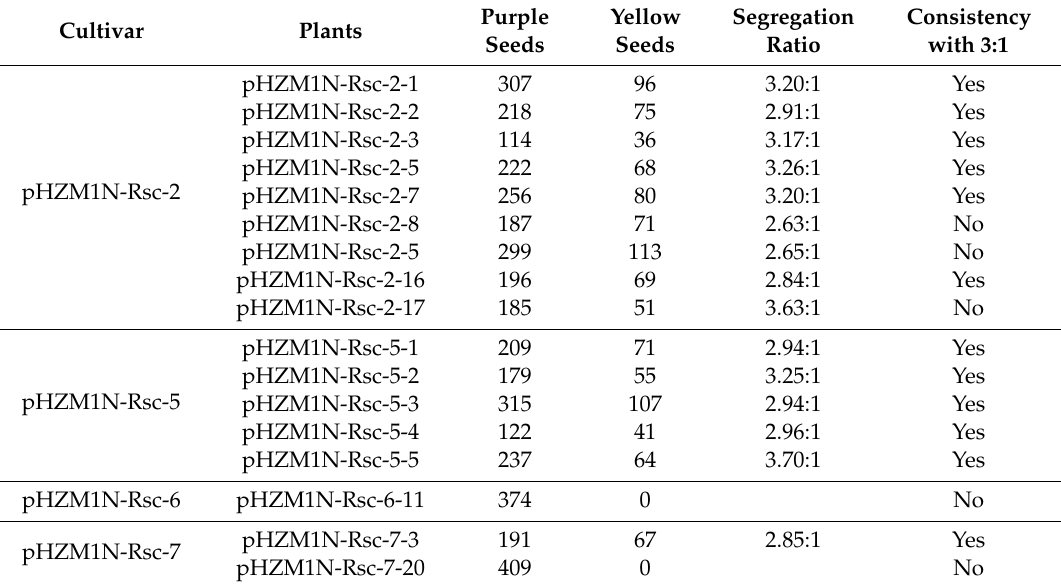
Table 4. Segregation ratio analysis of T 1